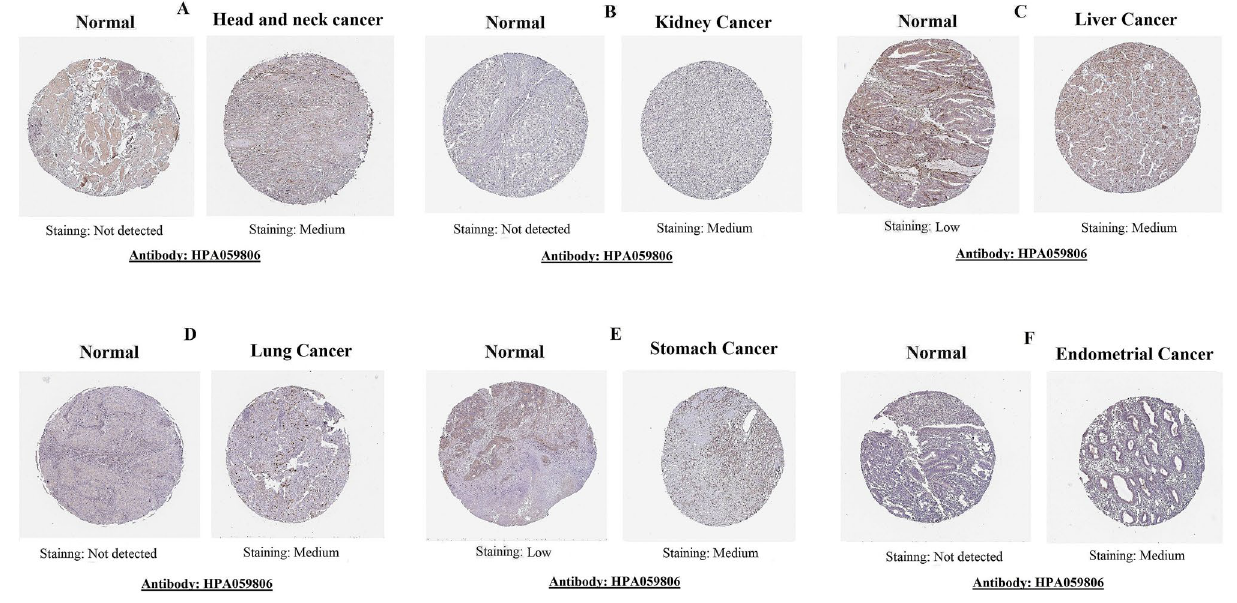
Figure 11. Translation expression of CTHRC1 across distinct cancer subtypes paired with normal controls taken from Human Protein Atlas (HPA) database (× 200). ( A ) Head and neck cancer, ( B ) kidney cancer, ( C ) liver cancer, ( D ) lung cancer, ( E ) stomach cancer, and ( F ) endometrial cancer.